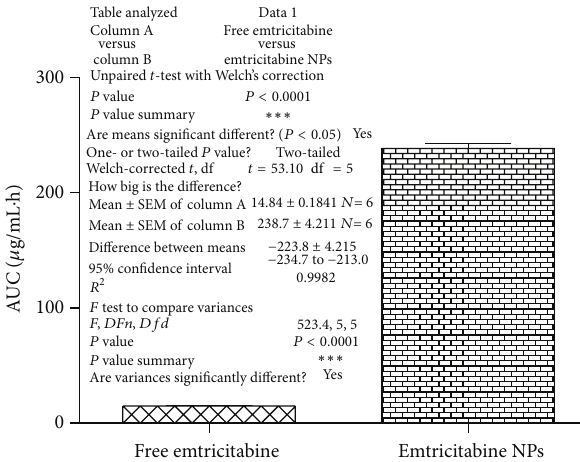
Figure 6: Comparison and effect of free emtricitabine and em- tricitabine NPs on AUC 0−∞ . Statistics: comparison based on AUC 0−∞ by two-tailed unpaired 𝑡 -test with Welch’s correlation test ∗∗∗ 𝑃 < 0.001 .